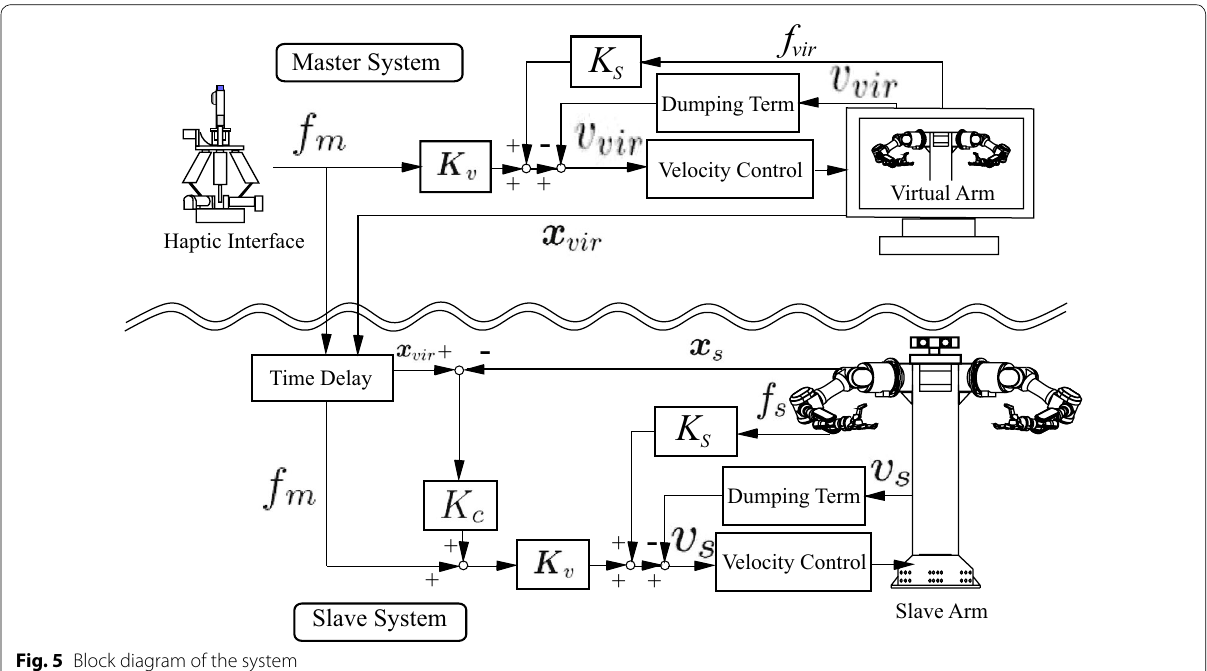
Fig. 5 Block diagram of the